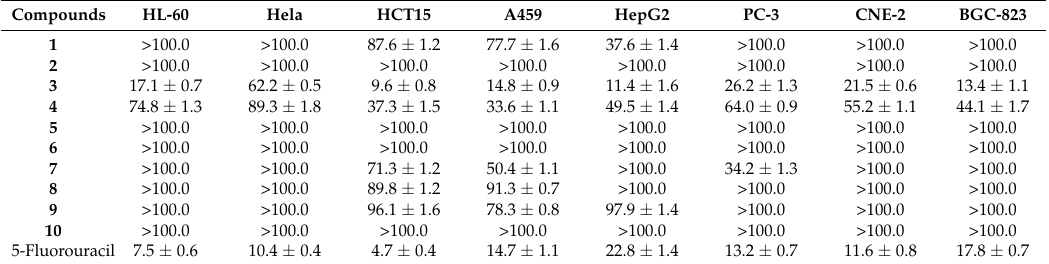
Table 3. In vitro antitumor activity of compounds 1 – 10 in a panel of 8 tumor cell